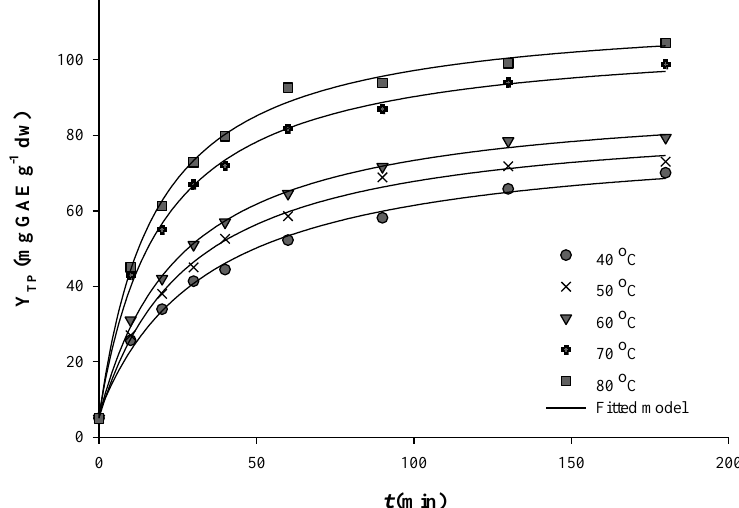
Figure 6. Kinetics of polyphenol extraction from S. fruticosa , traced under optimized conditions (S S = 900 rpm, C DES = 77% ( w / v ), and t US = 15 min).